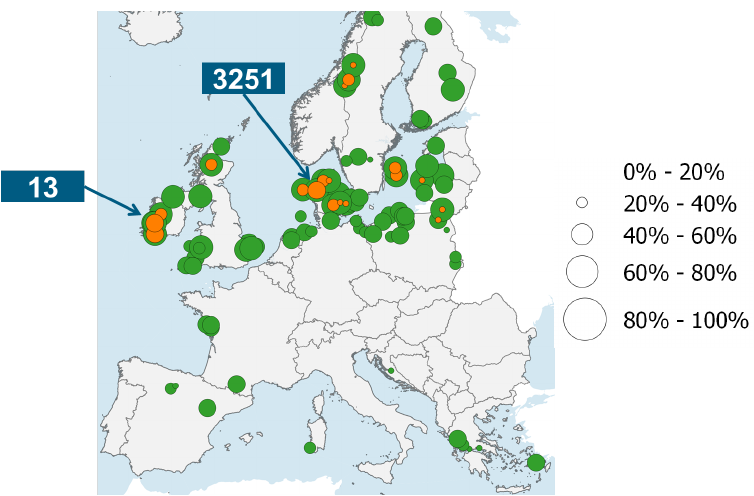
Figure 9. Duration curve of VRES curtailments at nodes “13” and “3152” (locations are depicted in Figure 10). The shaded areas correspond to the energy that can be extracted by an ideal converted.